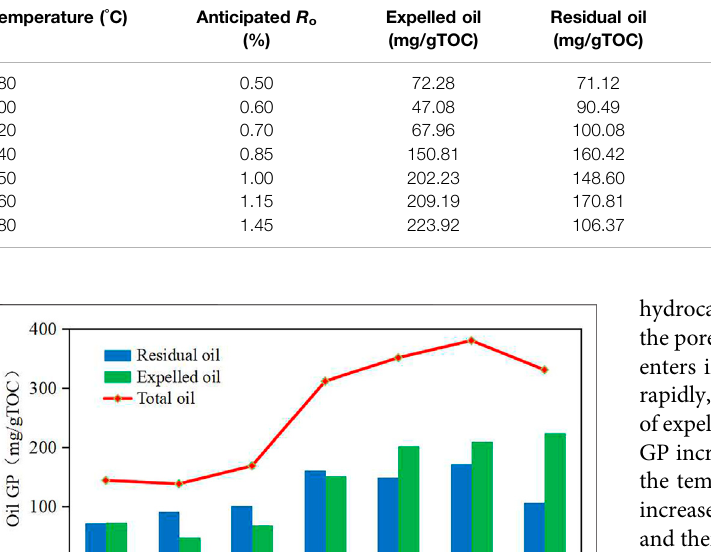
TABLE 3 | Simulation results of hydrocarbon generation and expulsion for stromatolite. Temperature ( ° C)